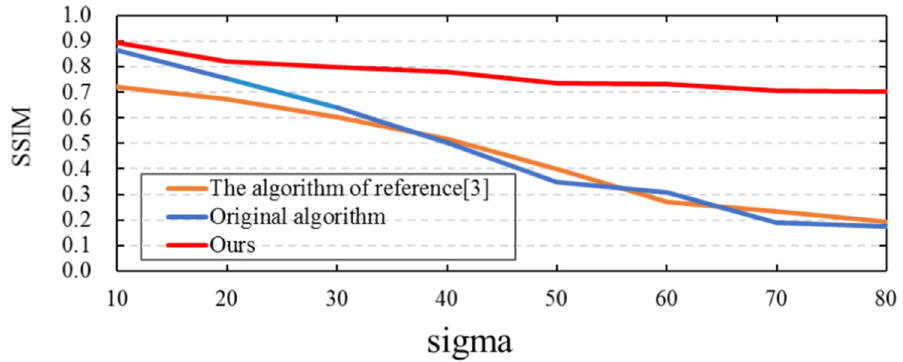
Figure 8. SSIM line chart of the three algorithms for the Monarch image.